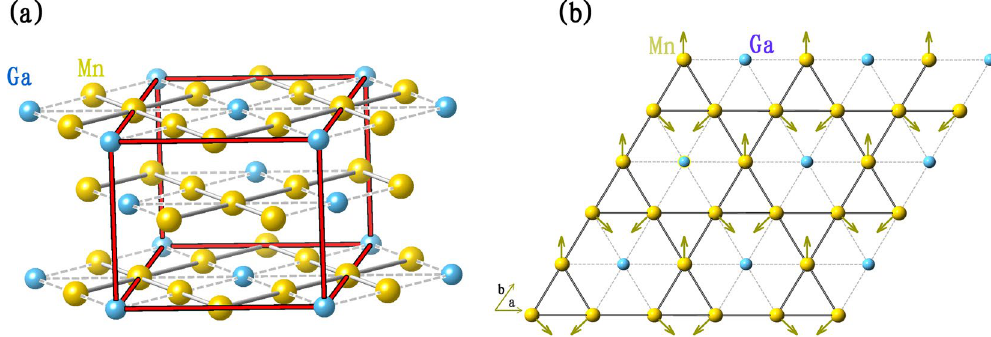
Figure 1. ( a ) The hexagonal structure of Mn 3 Ga, ( b ) An individual a - b plane of Mn 3 Ga. Mn moments (arrows) form a non-collinear AFM configuration 6, 7